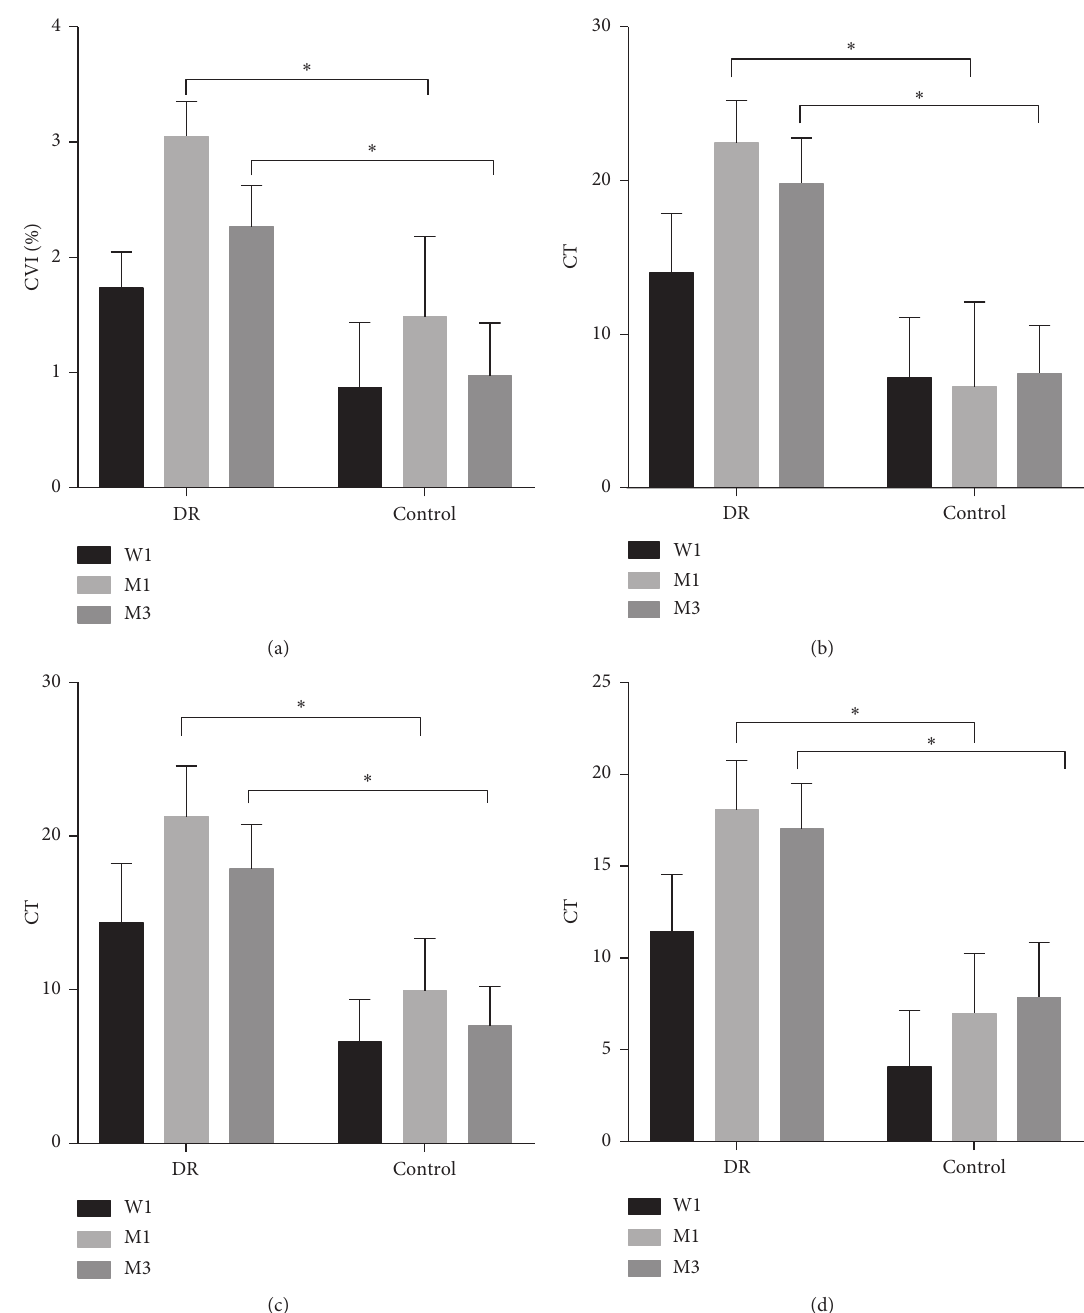
Figure 3: (a) Changes of CVI, (b) changes of foveal CT, (c) changes of parafoveal CT, and (d) changes of perifoveal CT for patients with mild/moderate NPDR (DR) and nondiabetic patients (control) at 1 week, 1 month, and 3 months postoperatively (mean ± SEM). W1: 1 wk postop; M1: 1 mo postop; M3: 3 mo postop. ∗ P < 0 .